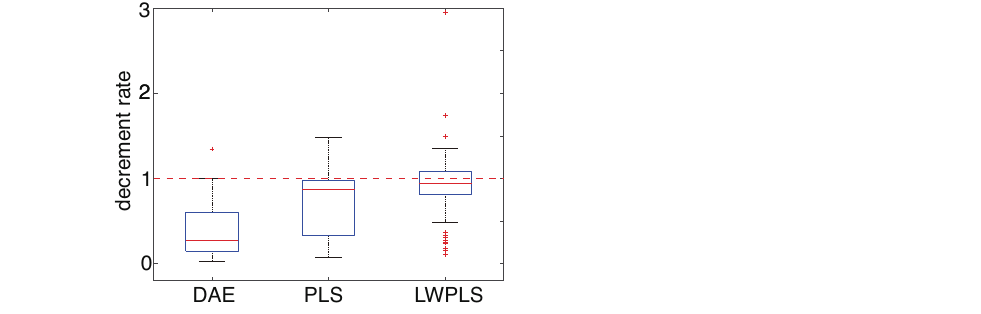
Figure 11. The RMSE decrement rates of the RRI data with PVC by DAE, PLS, and LWPLS. The pro- posed DAE achieved the best performance among the three methods.